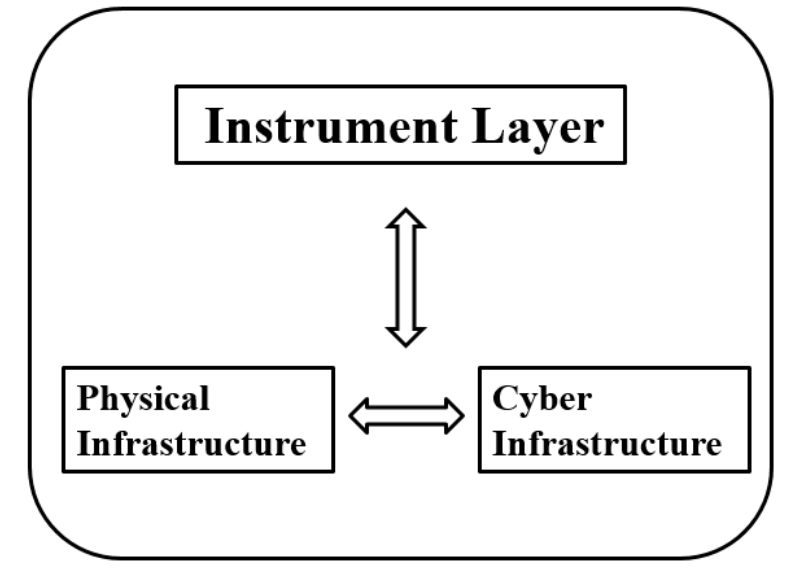
Figure 6. Designing of Instruments layer. Table 2. Components of Cyber-Infrastructure.